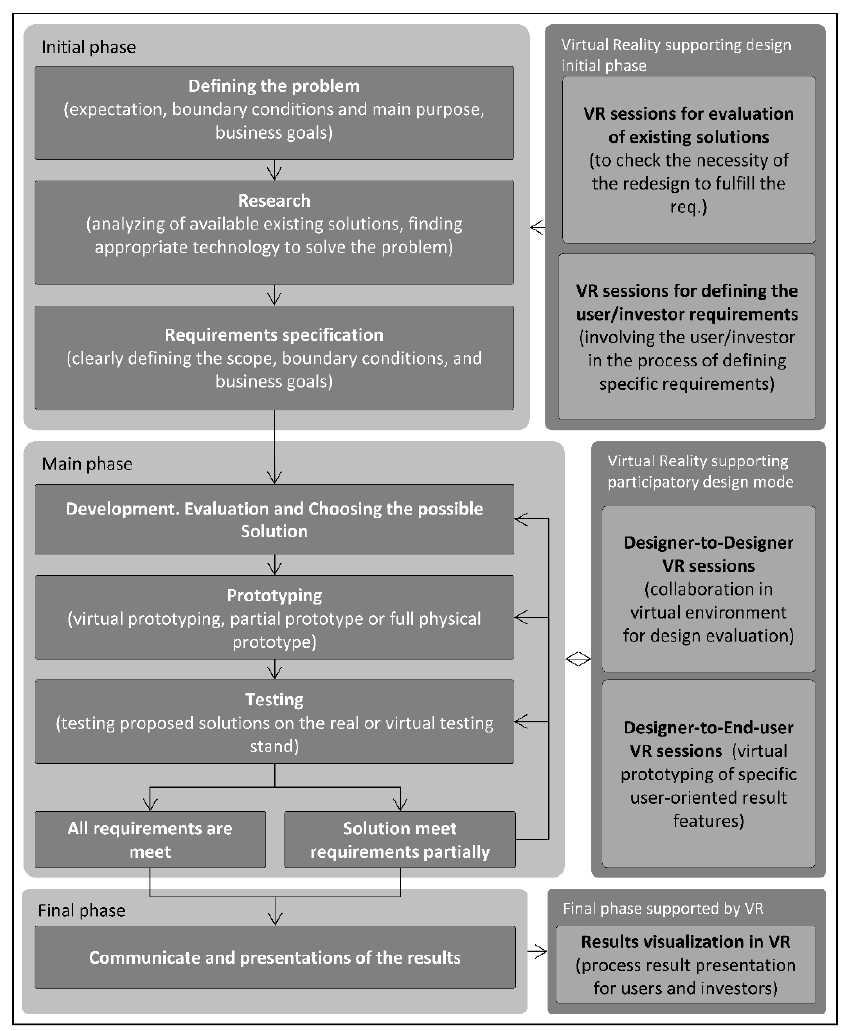
Figure 8. Possibilities of applying the Virtual Reality in the design